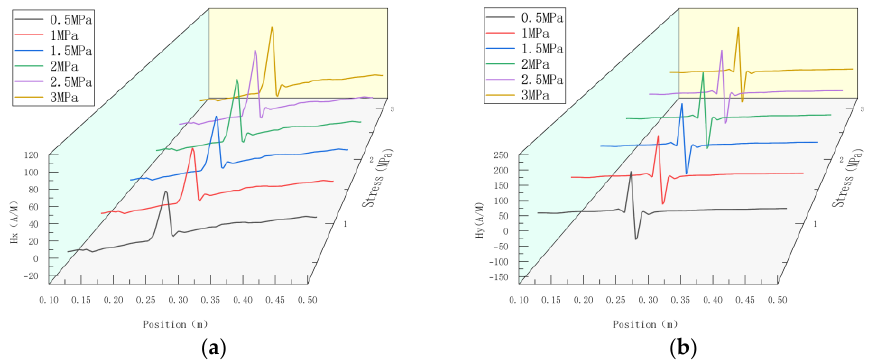
Figure 17. Magnetic signal of parent material crack under different internal pressure. ( a ) Axial component of weak magnetic signal; ( b ) radial component of weak magnetic signal.